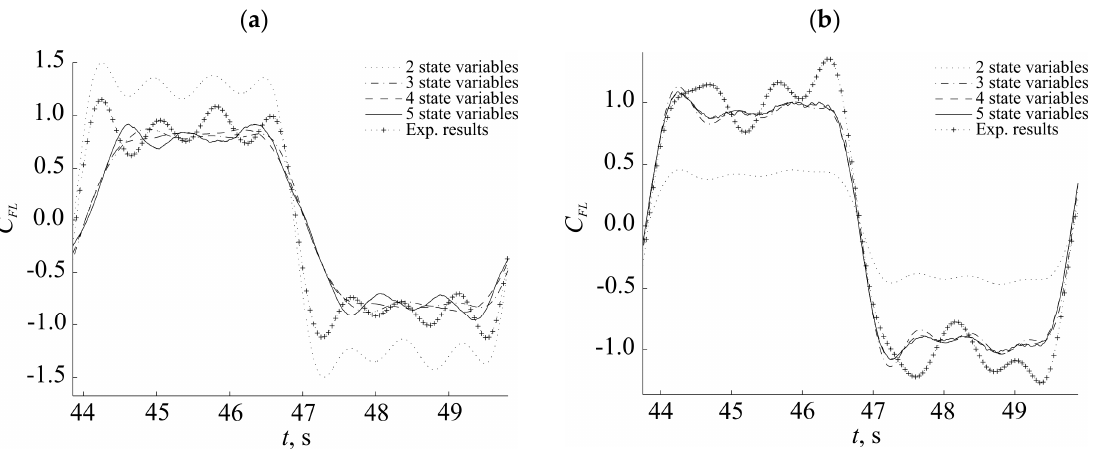
Figure 7. Time history of the lift force coefficient; comparison of measured data against calculated time response for two-, three-, four- and five-state variable models for: ( a ) model A and ( b ) model B.